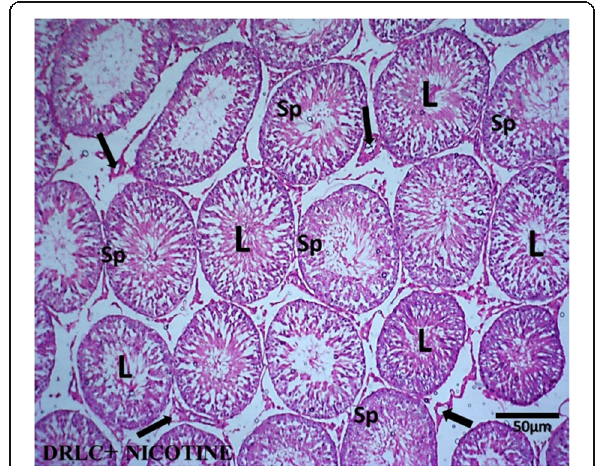
Fig. 15 Representative micrograph from the DRLC + nicotine group. Observe the seminiferous tubules with well-rounded outline. The germinal epithelium contains an array of spermatogenic cells (Sp). The lumina (L) also contains copious quantity of spermatids. Observe the small clear, interstitial arteries (block arrows). Stain H&E; Scalebar: 50 μ m